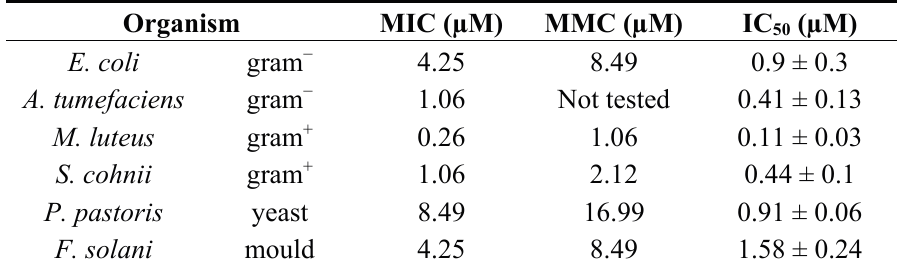
Table 1. Antimicrobial activity of recombinant